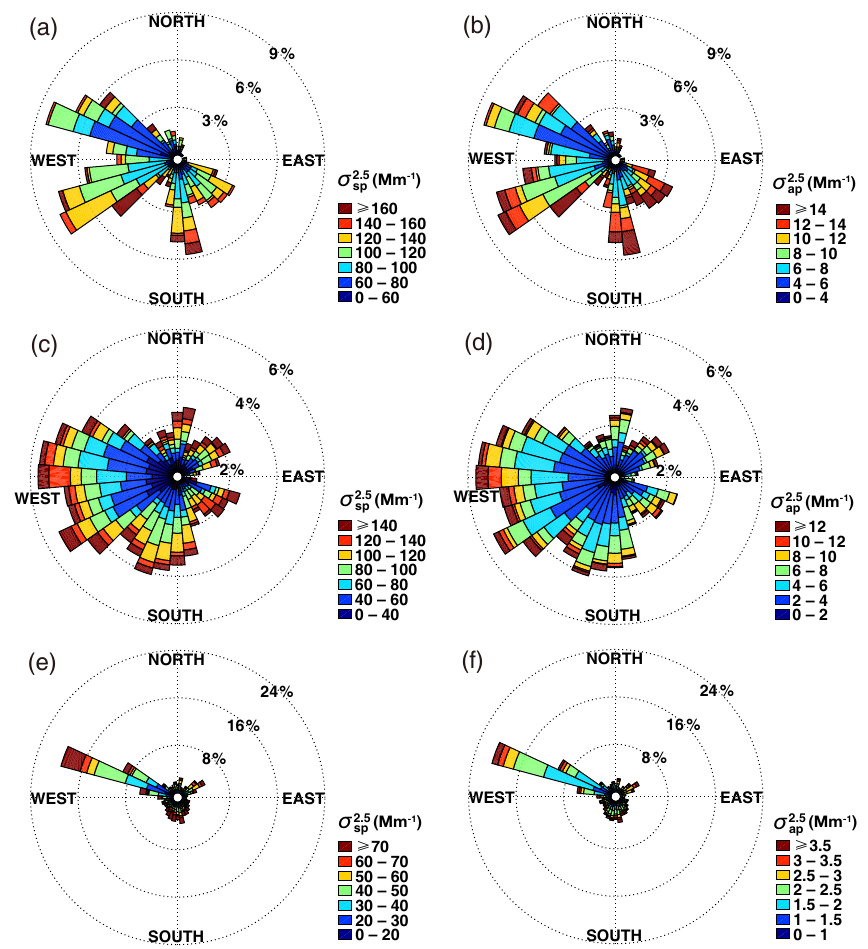
Figure 8. Wind roses for (a) aerosol scattering coefficient at 550nm and (b) aerosol absorption coefficient at 637nm in Wuwei. Panels (c) and (d) are the same as (a) and (b) but for Zhangye. Panels (e) and (f) are the same as (a) and (b) but for Dunhuang. Note that data collected during the strong dust storm in Zhangye are